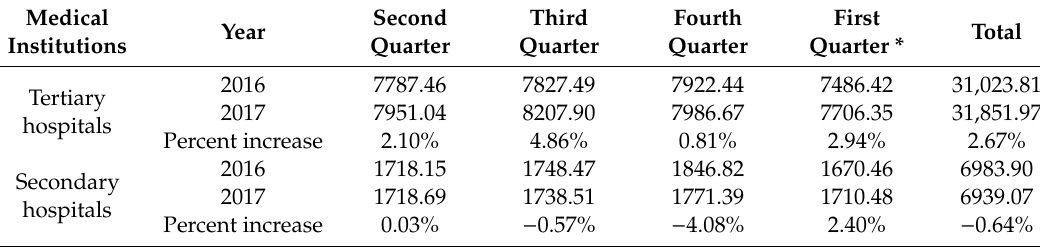
Table 4. The inpatient changes at each level of medical institution (person-times).